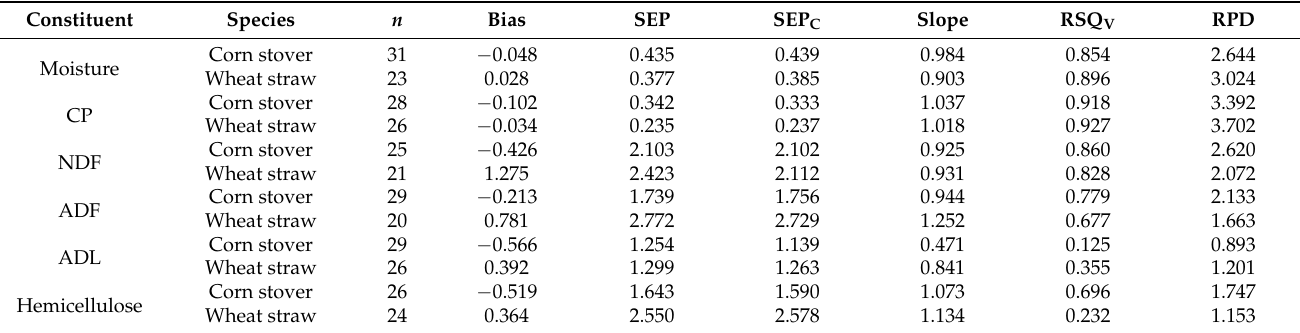
Table 4. Monitoring statistics for the NIR spectroscopic prediction equation for six constituents of corn stover and wheat straw.